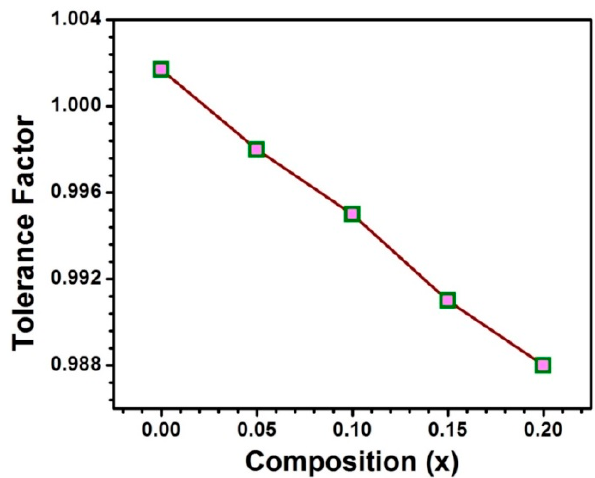
Figure 1. The tolerance factor with the compositions. Energies 2019 , 12 , x FOR PEER REVIEW